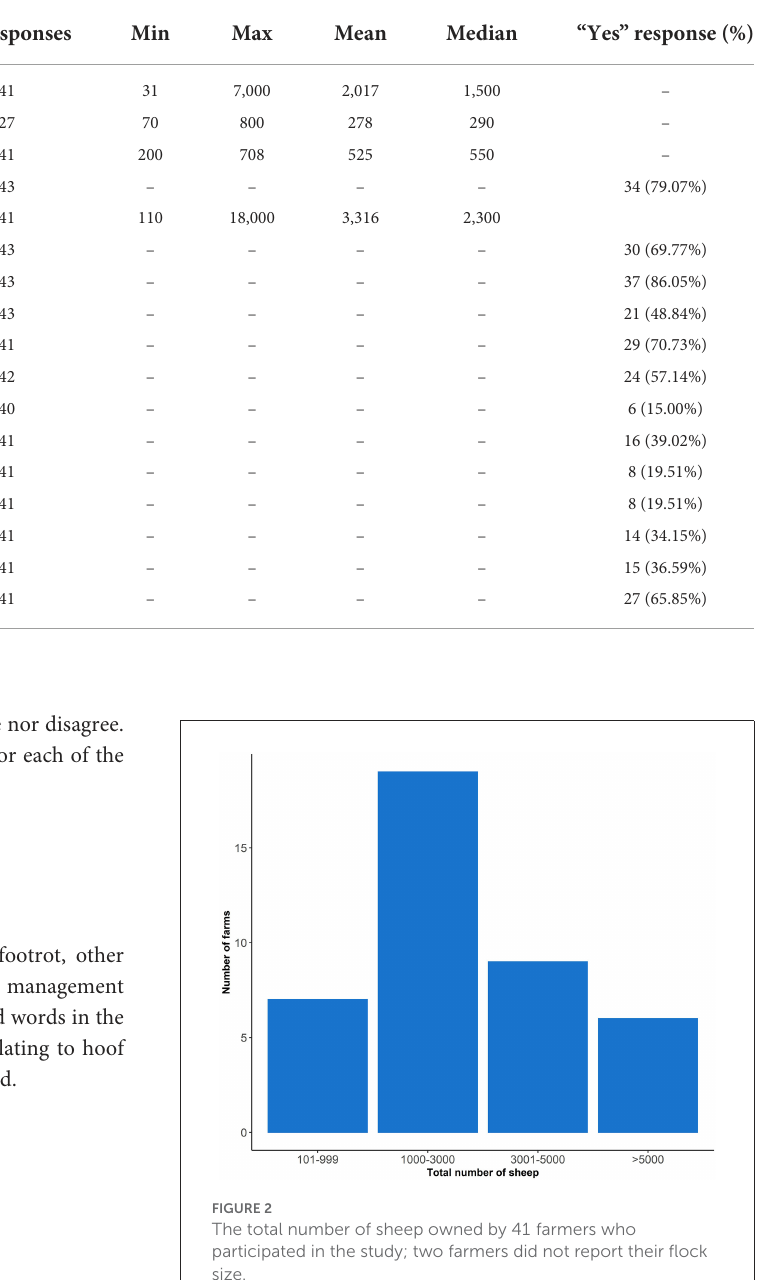
TABLE 2 Summary of the farm information, production type and hoof diseases present in farms included in the survey. Variable